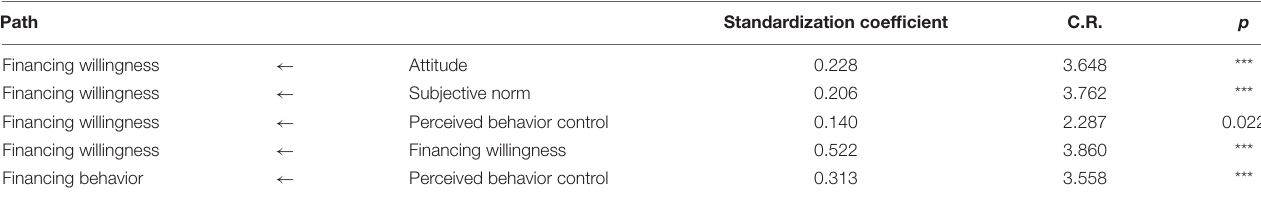
TABLE 7 | Path analysis.